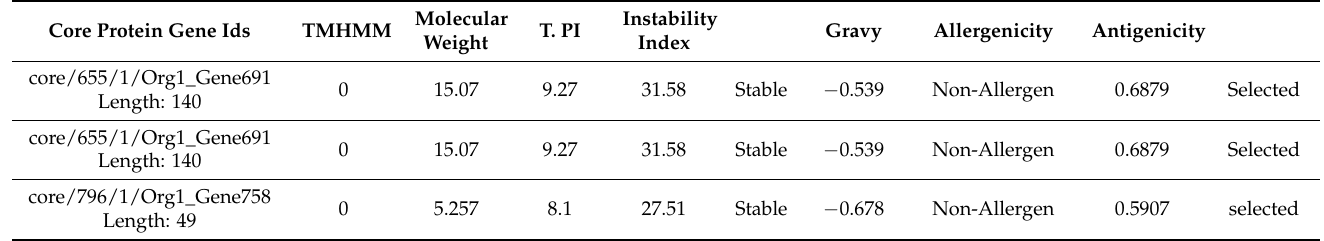
Table 1. Physiochemical properties of proteins shortlisted for vaccine